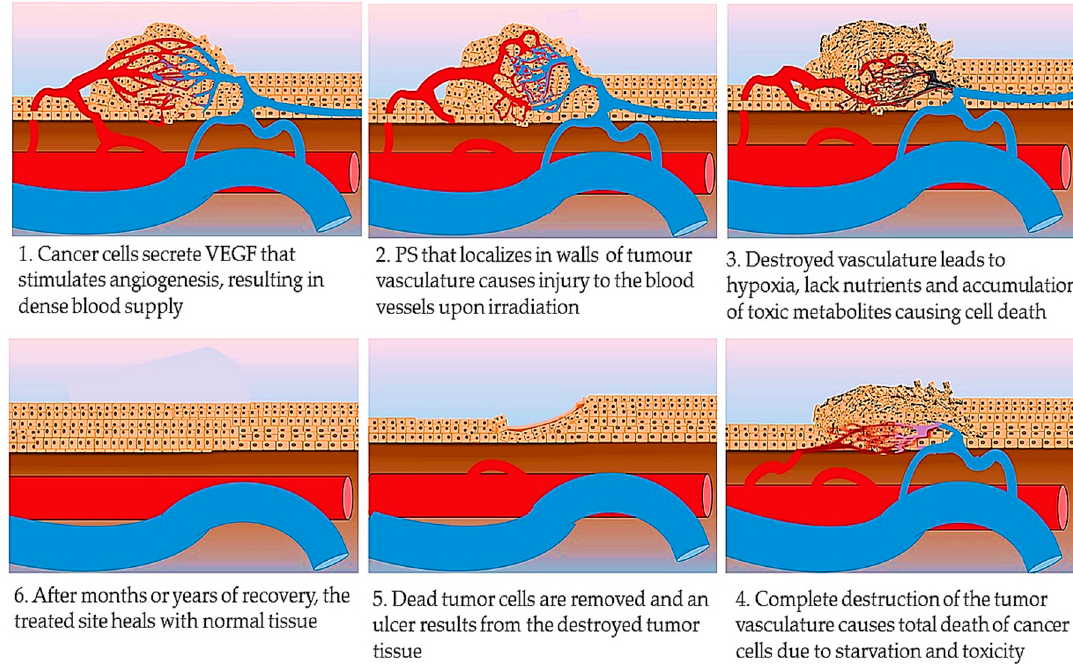
Figure 4. Tumor vasculature targeted PDT. Depletion of the tumor vasculature results in tumor nutrient deprivation leading to complete tumor tissue destruction.